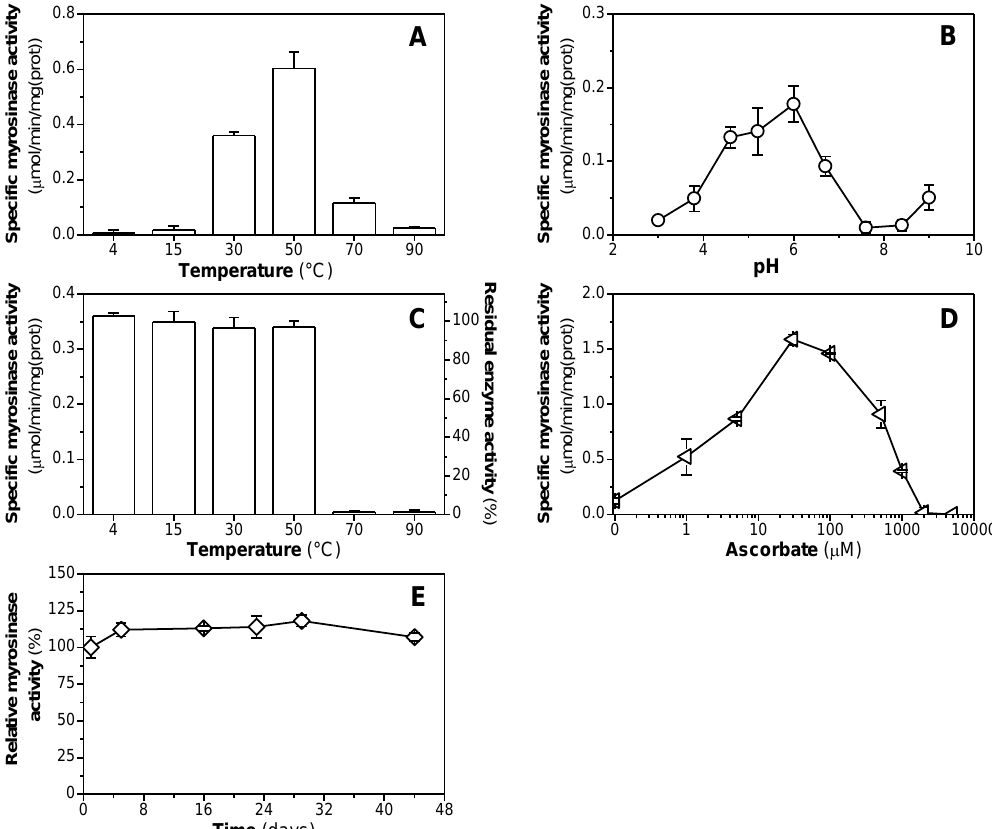
Figure 5. Characterization of effects of temperature ( A ), pH ( B ), thermal inactivation ( C ), concentration of ascorbic acid ( D ), and long-term storage stability at 4 °C ( E ) on the rate of sinigrin hydrolysis catalyzed by myrosinase purified. The enzyme activities were measured at 5 mM concentration of sinigrin in the presence of 1 mM L-ascorbic acid.